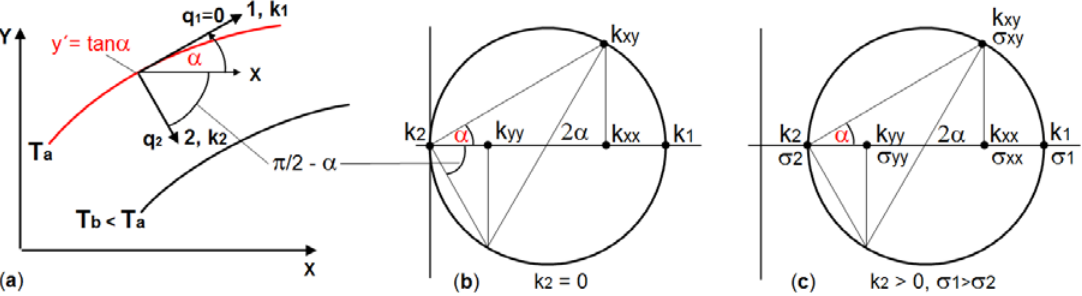
Figure 2. Transformation between local and global conductivity tensors k in the temperature field T(x,y) : ( a ) Angle α and ( π /2) − α between the local system (1,2) and the global x-axis, q = heat flux density; ( b ) Mohr’s Circle for k 1 > 0 and k 2 = 0; ( c ) Mohr’s Circle for k 1 > 0 and k 2 > 0 by analogy with Mohr’s Stress Circle.